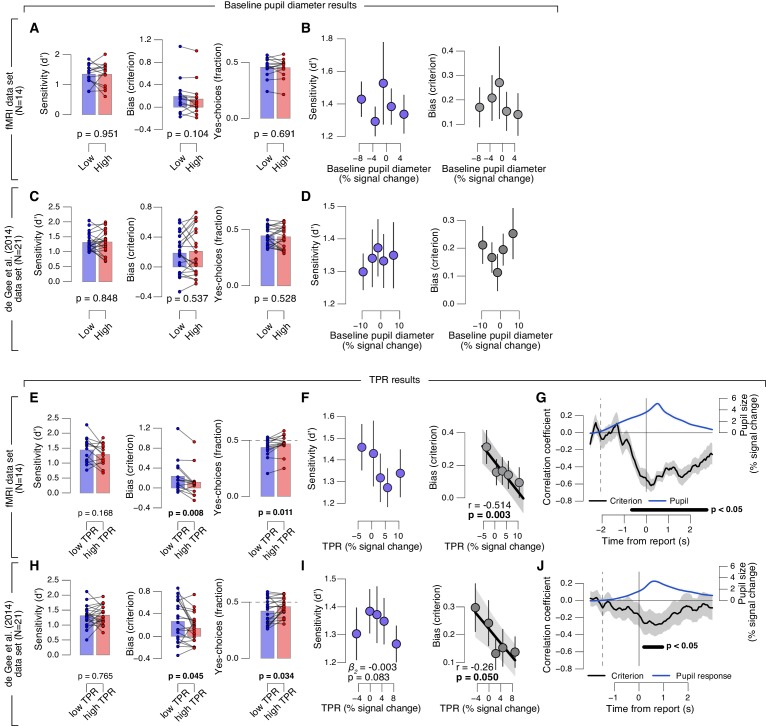
Phasic arousal predicts reduction of choice bias.(A–D) As main Figure 2 panels A, B, D, E, but now after splitting trials by (or as a function of) baseline pupil diameter, quantified as the mean pupil size in the 0.5 s before decision interval onset. (E–J) As main Figure 2 panels A-F, but now without removing trial-to-trial variations from TPR due to reaction time (RT). The pattern of results is qualitatively identical to the one in Figure 2. All panels: group average (N = 14); shading or error bars, s.e.m.; stats, permutation test. Panels A, C, E, H: data points, individual subjects.